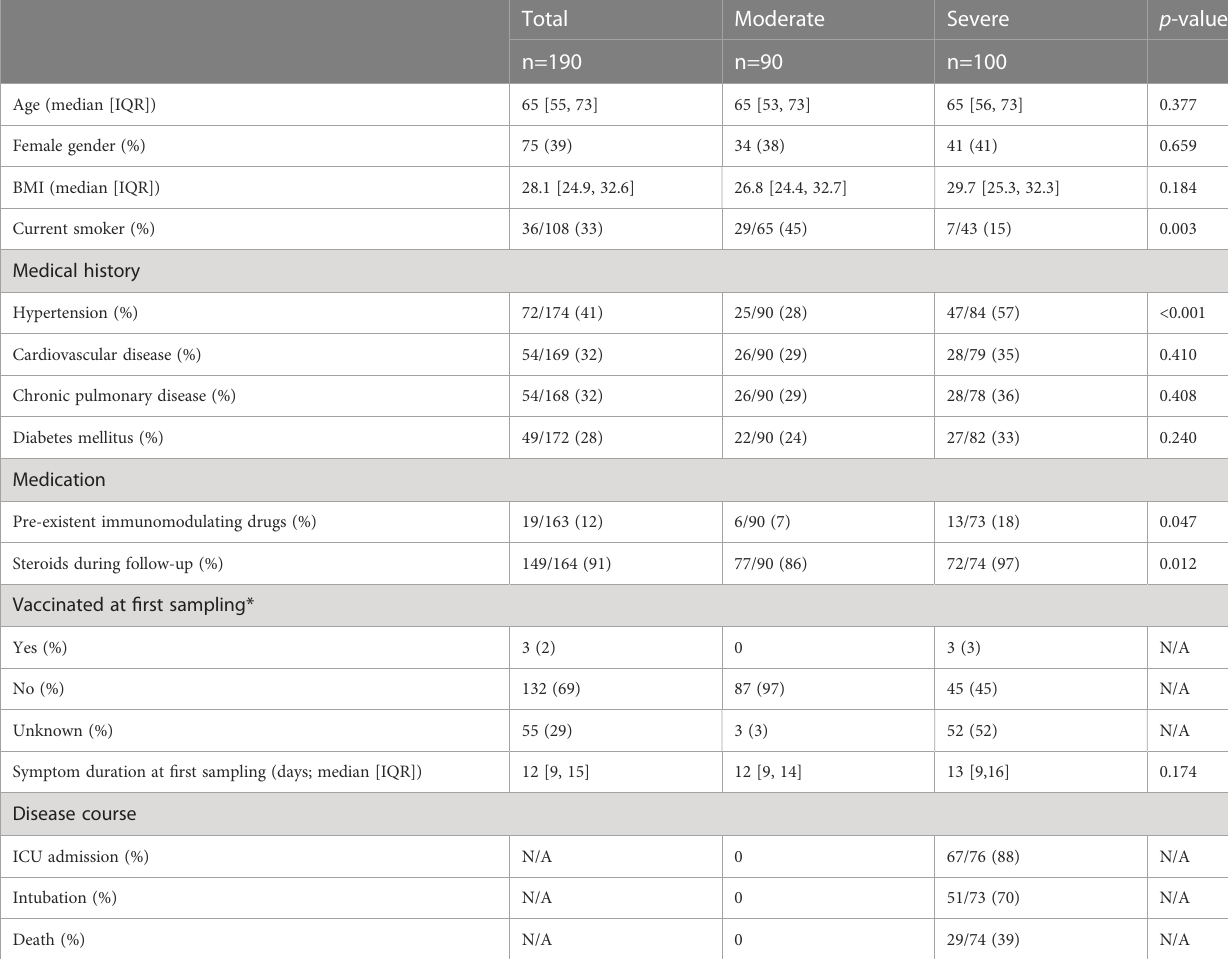
TABLE 1 Baseline characteristics of hospitalized patients with moderate or severe